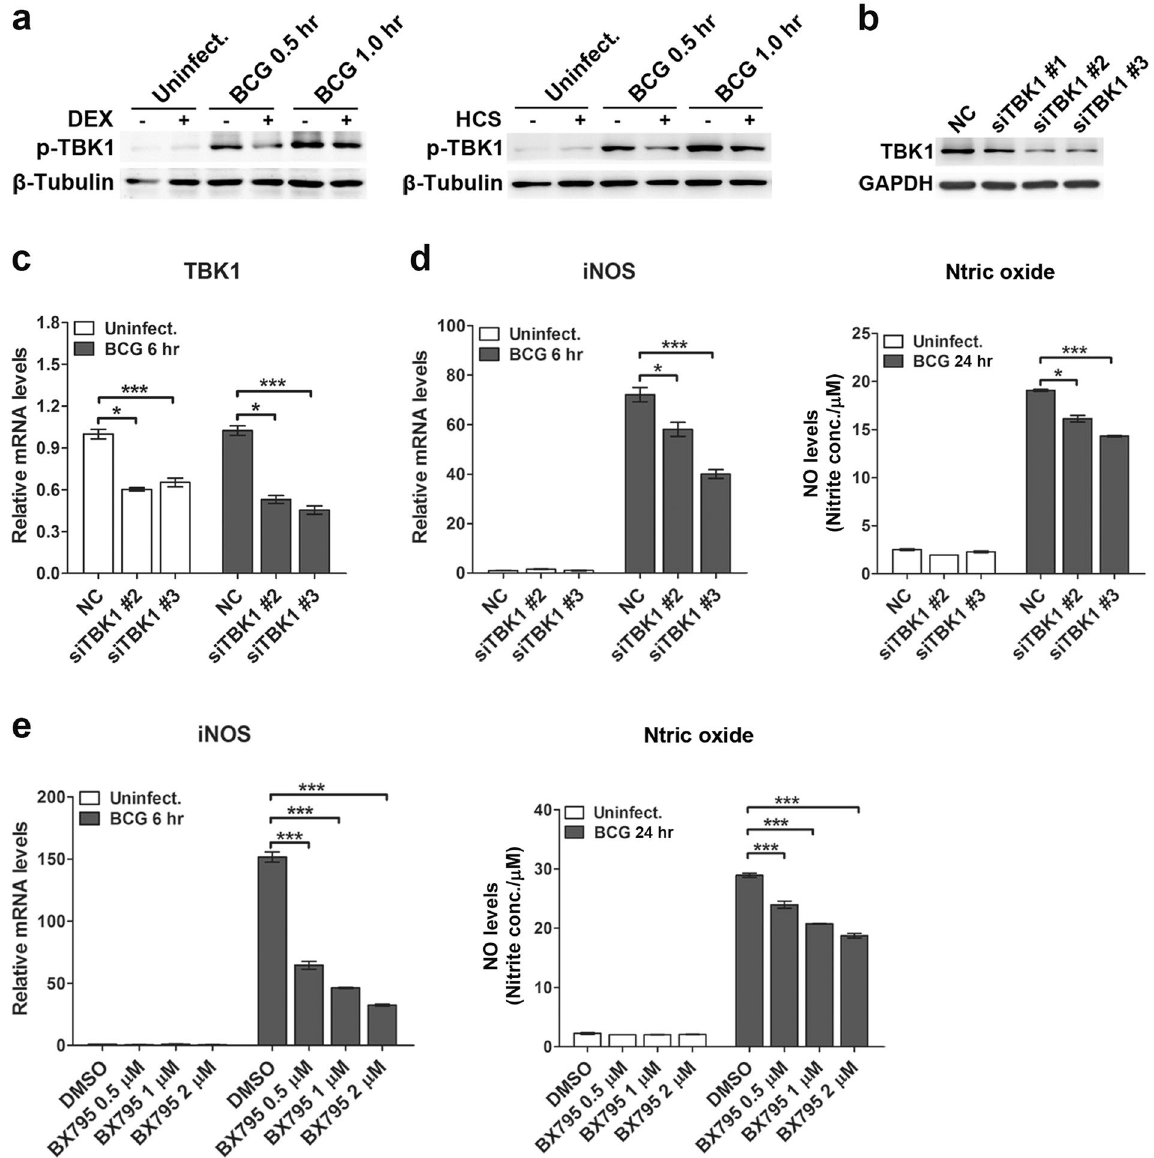
Figure 5. Glucocorticoids inhibit TBK1 activation, and TBK1 silencing decreases iNOS expression and NO production in macrophages during mycobacterial infection. ( a ) RAW264.7 cells were pretreated with dexamethasone (DEX) (1 μ M), hydrocortisone (HCS) (1 μ M) or vehicle control ethanol (mock) for 24 hr and then challenged with M. bovis BCG (MOI 5) for the indicated times. Then the phosphorylation level of TBK1 was tested with Western blot analysis. Full-length blots are presented in Supplementary Fig. 8. ( b ) RAW264.7 cells were transfected with control siRNA (NC) or three TBK1 siRNAs (siTBK1 #1, #2, #3) with different sequences for 24 hr, and the protein level of TBK1 was tested with Western blot. Full-length blots are presented in Supplementary Fig. 9. ( c , d ) RAW264.7 cells were transfected with NC or siTBK1 #2 or #3 for 24 hr, and then infected with M. bovis BCG for the indicated times. TBK1 ( c ) and iNOS ( d ) mRNA level were tested with real- time PCR. NO in the supernatant was detected with the Griess assay ( d ). ( e ) RAW264.7 cells were pretreated with a TBK1 inhibitor (BX795) at the indicated concentration for 1 hr, and then infected with M. bovis BCG for the indicated times. iNOS mRNA levels were tested with real-time PCR. NO in the supernatant was detected with the Griess assay. For Western blot analysis, β -Tubulin or GAPDH was used as a loading control, and data are representative of three independent experiments with similar results. For real-time PCR, the level of each mRNA was normalized to that of β -actin mRNA and is expressed relative to expression in unstimulated cells. Data are shown as the mean ± SEM of three independent experiments. * p < 0.05; *** p <